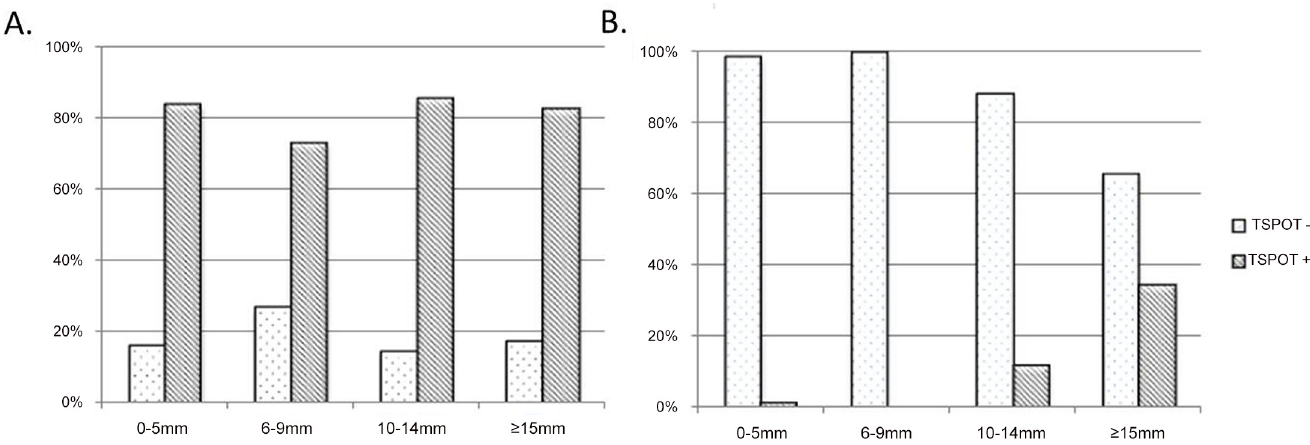
Fig 3. Distribution of positive T-SPOT. TB results in active TB (A) and RTIs (B) children with different TST induration